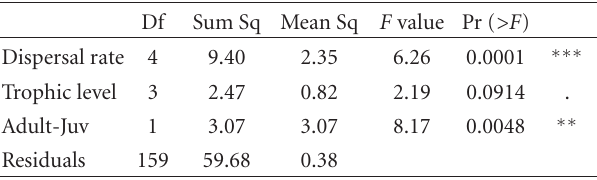
Table 1: Analysis of variance of biomass change in MPAs against dispersal rates, trophic level, and adult versus juvenile life